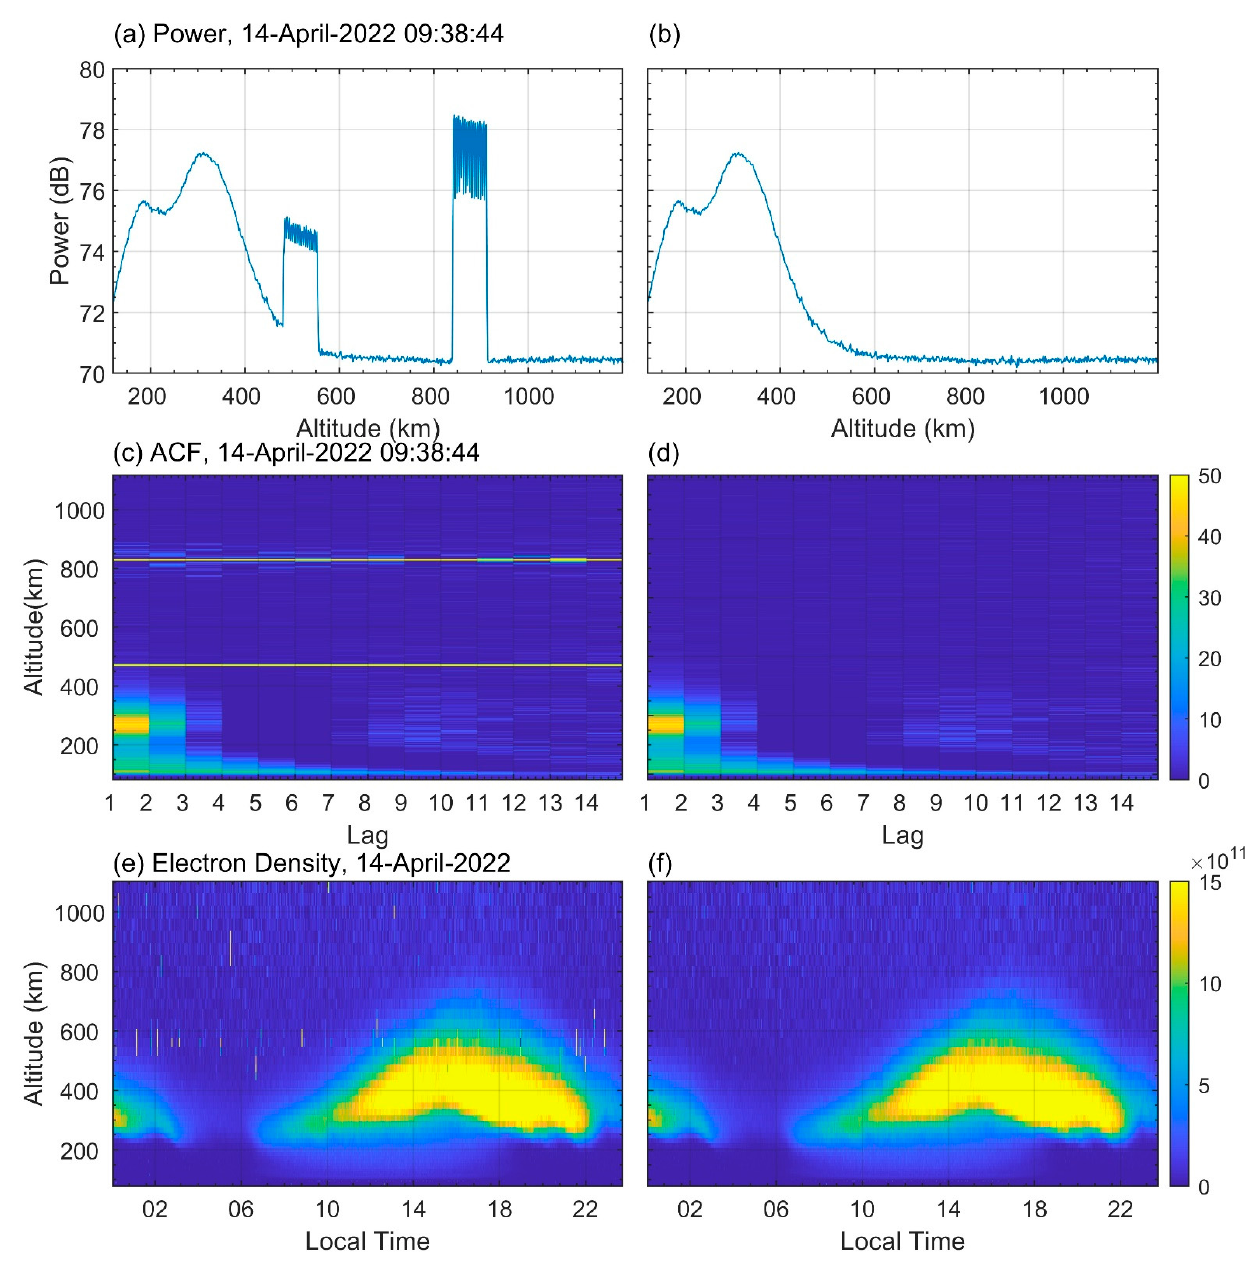
Figure 4. An example of power profile (( a , b ) unit: dB) and autocorrelation function (( c , d ) ACF) of SYISR ionospheric measurement observed on 14 April 2022 at 09:38:44 using an alternating code (AC) signal. Panels ( e , f ) show the retrieved electron density profiles during the entire day of 14 April 2022. The left (right) column shows the results before (after) eliminating the space object pollution.